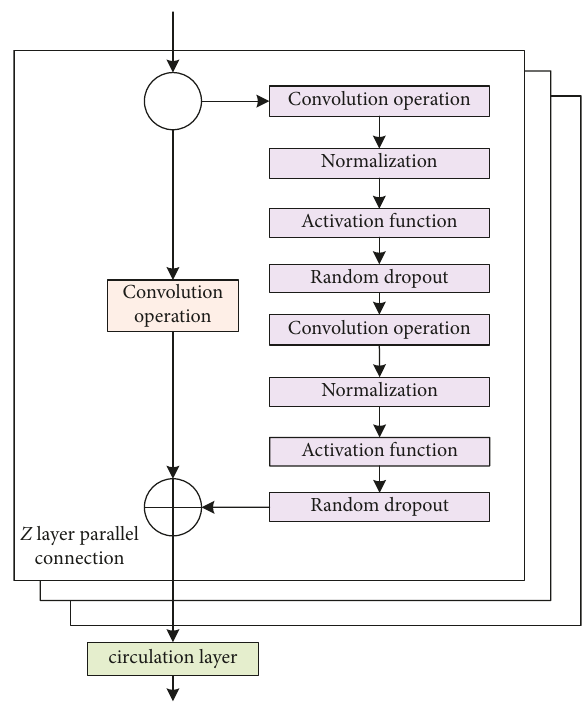
Figure 6: Residual mapping